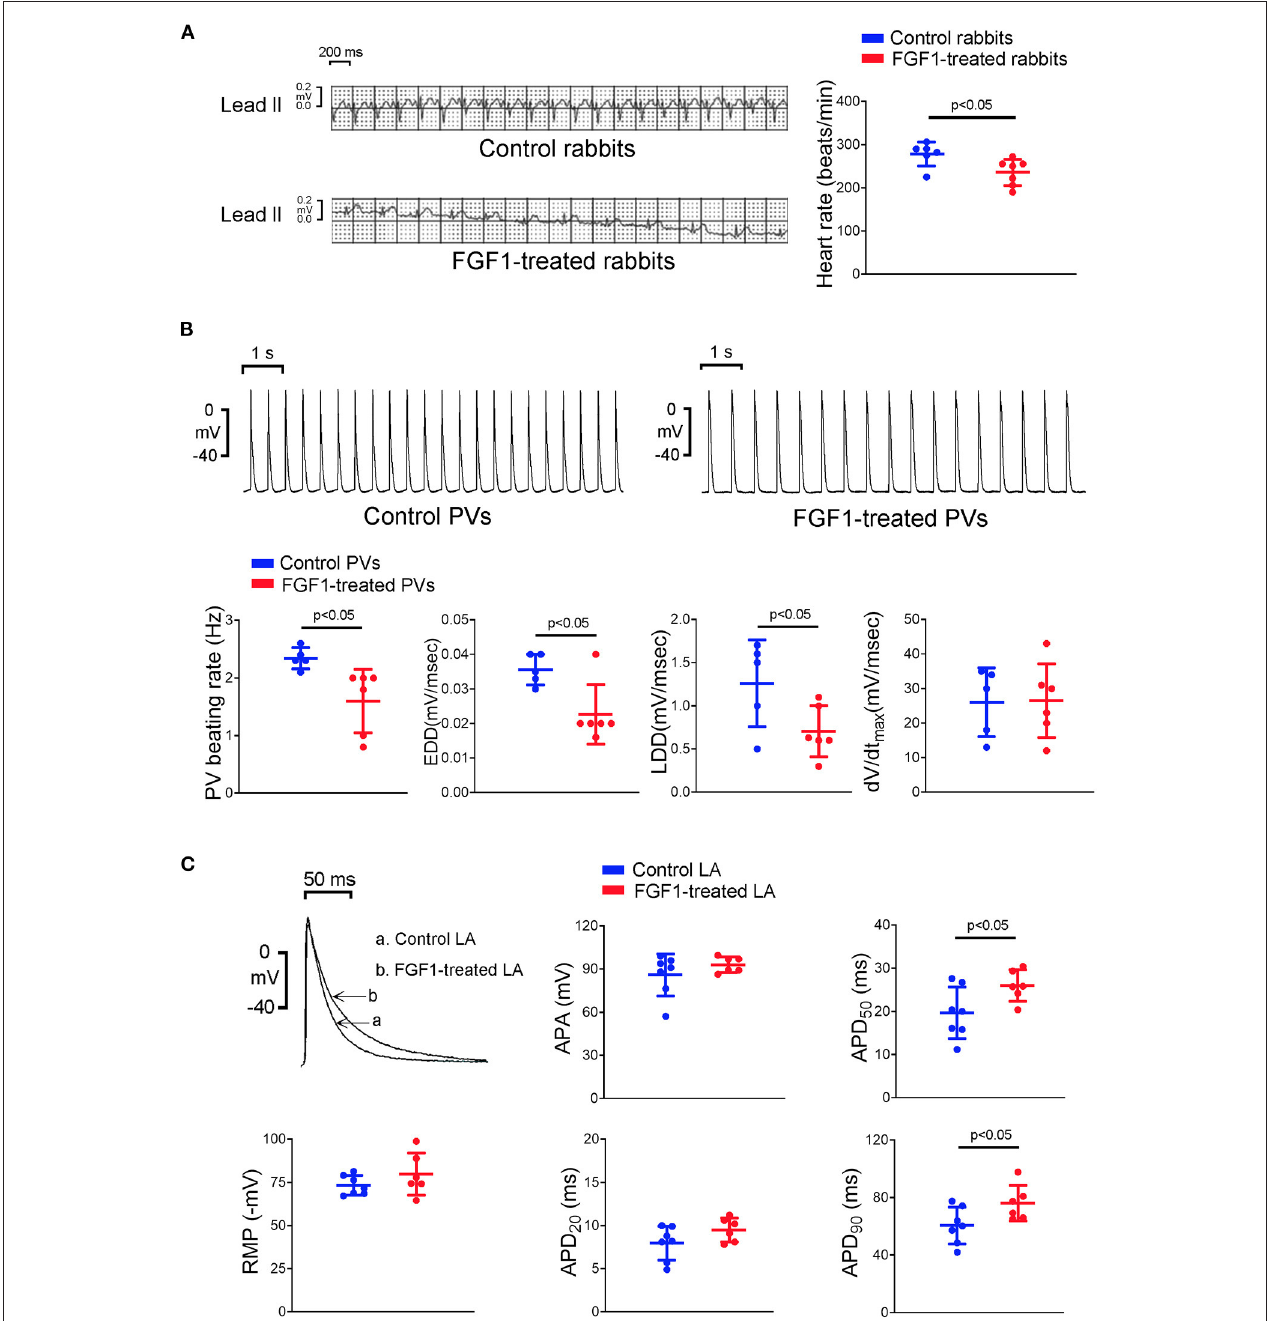
FIGURE 1 | Effects of fibroblast growth factor 1 (FGF1) on the electrocardiography (ECG) of rabbits and electrophysiological characteristics of pulmonary vein (PV) and left atrial (LA) tissues. (A) Control rabbits ( N = 6) had a faster regular rhythm than that observed in FGF1 (3 µ g/kg)-treated rabbits ( N = 6). (B) Tracings and scatter plots illustrated that PV tissues of FGF1 (3 µ g/kg)-treated rabbits ( N = 6) had a slower spontaneous activities with a decreased early and late diastolic depolarization than that observed in control rabbits ( N = 5). (C) Examples and scatter plots of the action potential (AP) morphology from LA tissues under regular pacing (2Hz) in the control ( N = 7) and FGF1 (3 µ g/kg)-treated rabbits ( N = 6). RMP indicates resting membrane potential, APA indicates AP amplitude, APD 20 , APD 50, and APD 90 indicate that AP duration at 20, 50, and 90% repolarization of the amplitude, respectively, EDD indicates early diastolic depolarization, LDD indicates late diastolic depolarization, dV/dt max indicates maximum upstroke